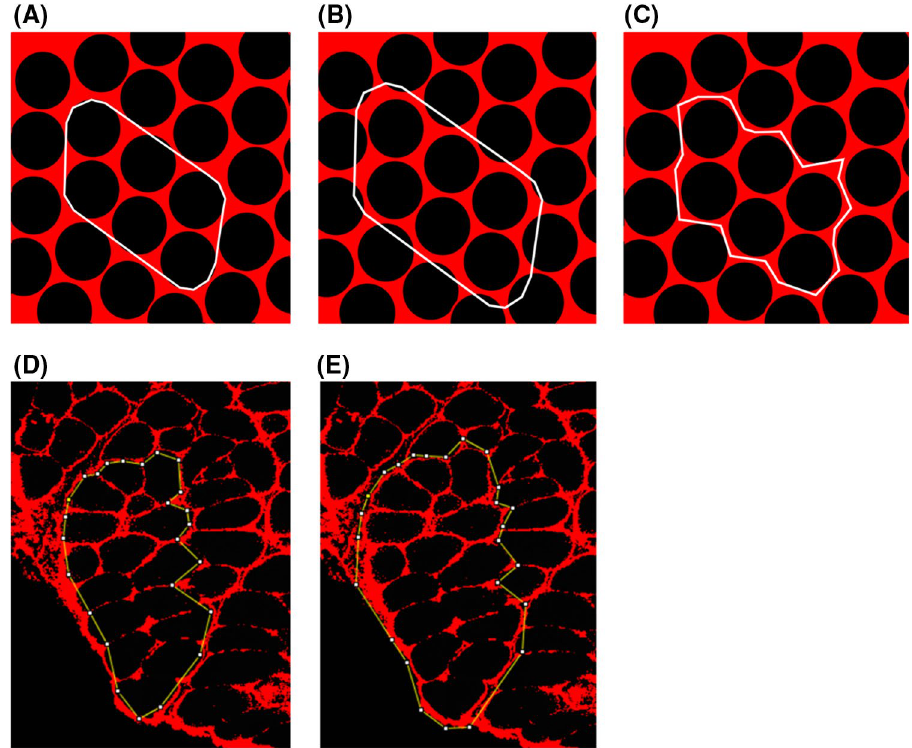
Figure 5. Segmentation of fiber bundles from immunohistochemistry images. Two segmentations were performed for each bundle: the borders of one segmentation (type A) passed internal to the edge of boundary fibers of the bundle ( A , D ), while borders of the other segmentation (type B) passed externally, including the boundary edge of the fibers immediately adjacent but external to the bundle ( B , E ). Schematic representations for a simulated bundle of 6 fibers, are shown for segmentation type A ( A ), segmentation type B ( B ), and how a real bundle may present ( C ). The collagen I deposition was measured for the two segmentations ( D , E ) and their average was considered for the selected bundle.